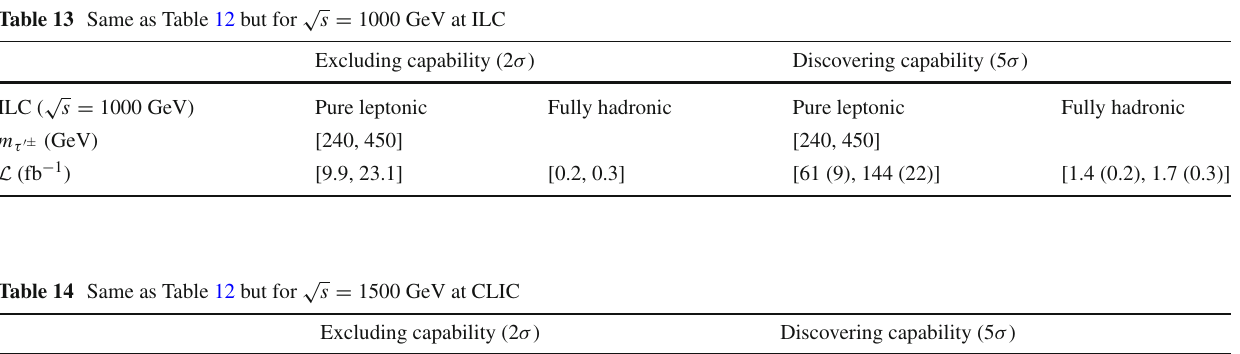
√ s = 1000 GeV at ILC